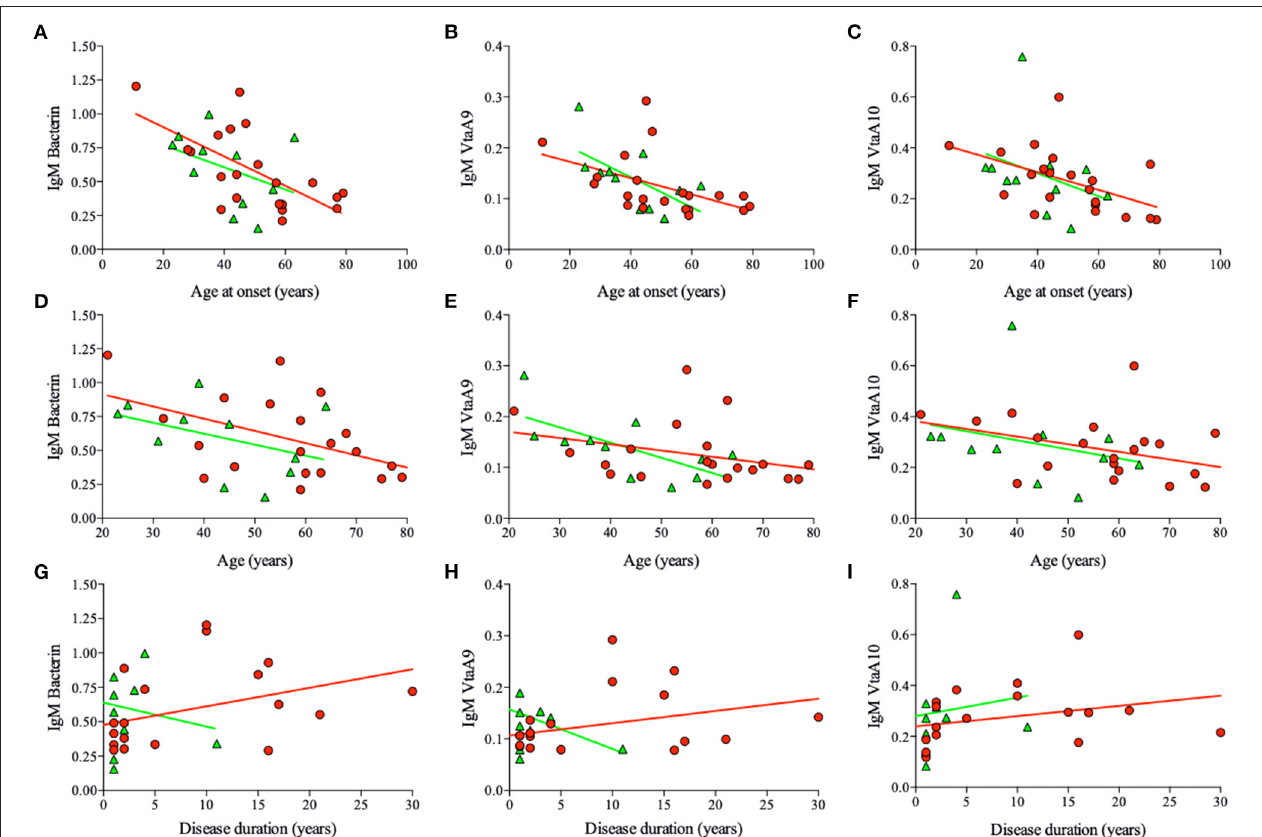
FIGURE 2 | Hps specific IgM titers and main correlations. Correlation between IgM titers specific for Bacterin, VtaA9, and VtaA10, specific for Hps , and Age at the onset, Age, and disease duration from the sera of the RA (red circles) and UPIA (green triangles) patients. In RA IgM titers inversely correlate with age at onset ( A , bacterin, r = − 0.55, p = 0.01. B , VtaA9, r = − 0.41, p = 0.05. C , VtaA10, r = − 0.40, p = 0.02), age ( D , ns; p = 0.02. E , ns. F , ns), and directly correlate with the disease duration ( G , bacterin, r = 0.38, p = 0.07. H , ns. I , ns.). In UPIA patients IgM titers inversely correlate with the age at the onset ( B , VtaA9, r = − 0.60, p = 0.09) and the age ( E , VtaA9, r = − 0.69, p =